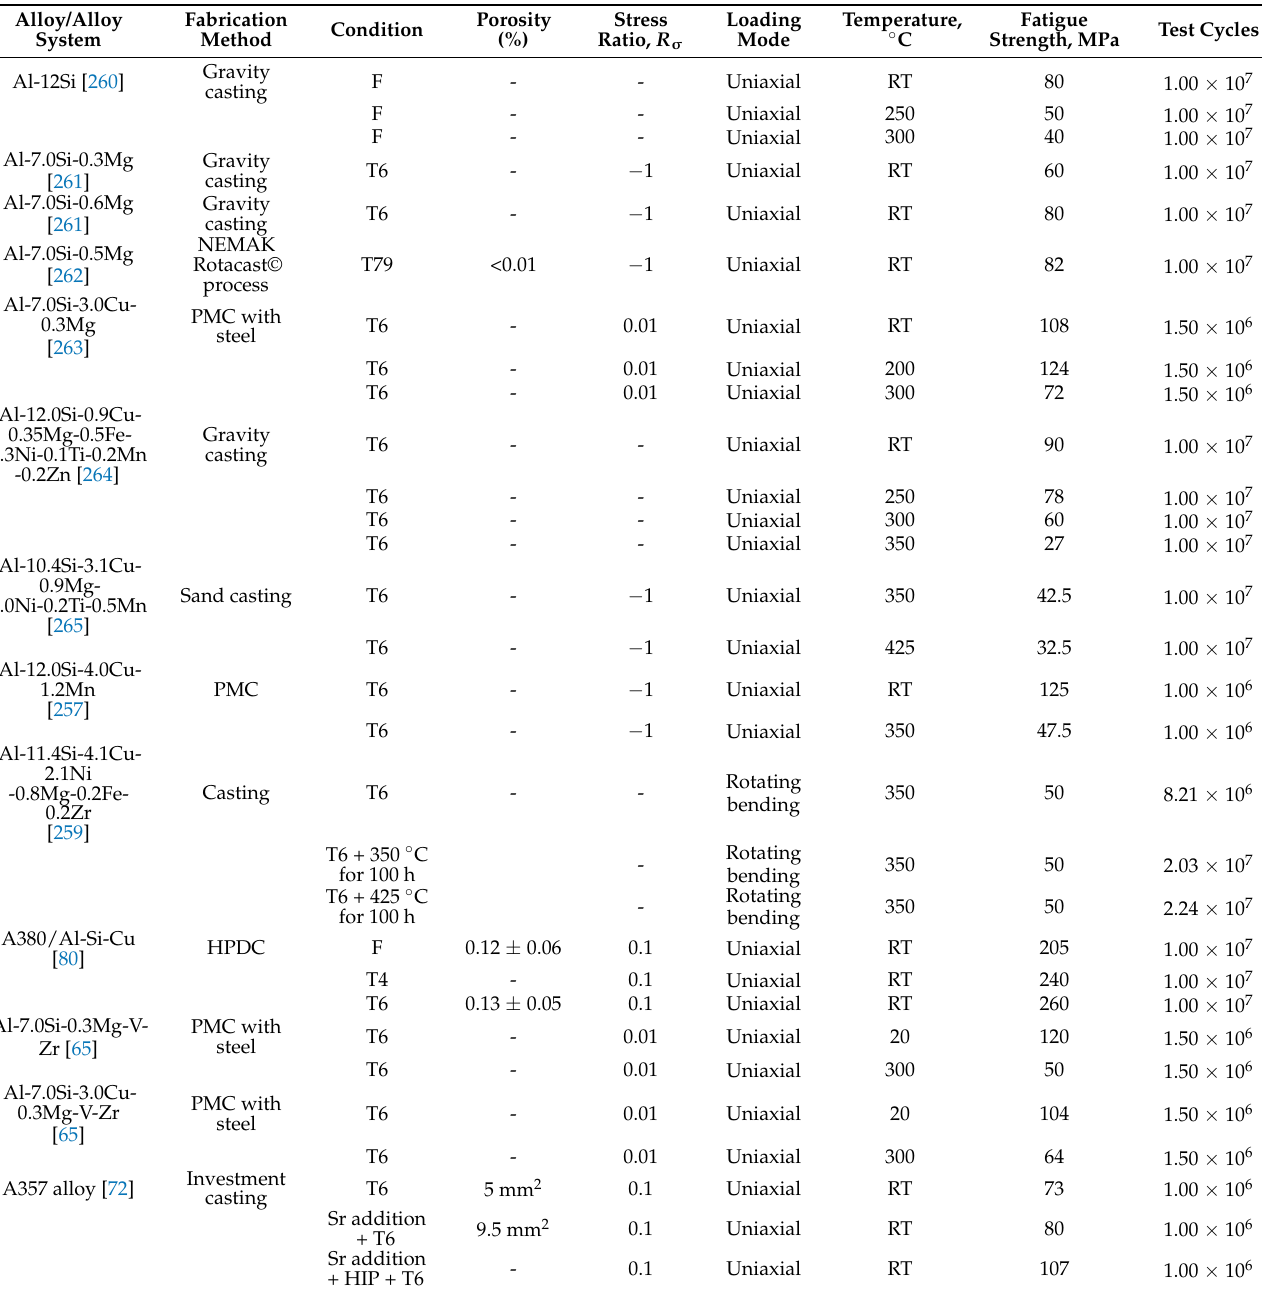
Table 5. HCF properties of some recently developed structural Al-Si